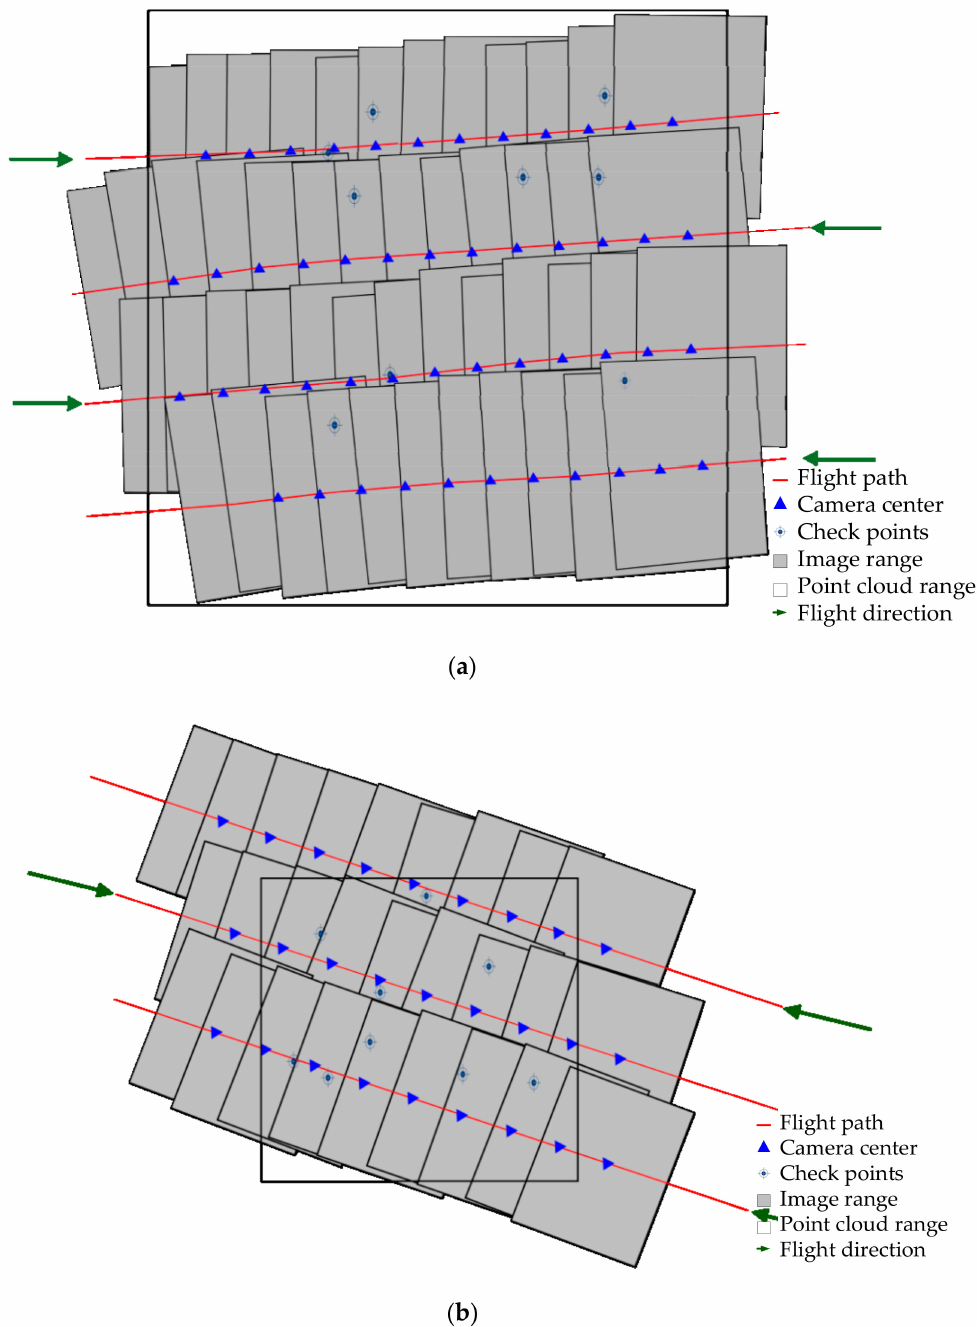
Figure 2. Block layout configuration: ( a ) Dataset 1; and ( b ) Dataset